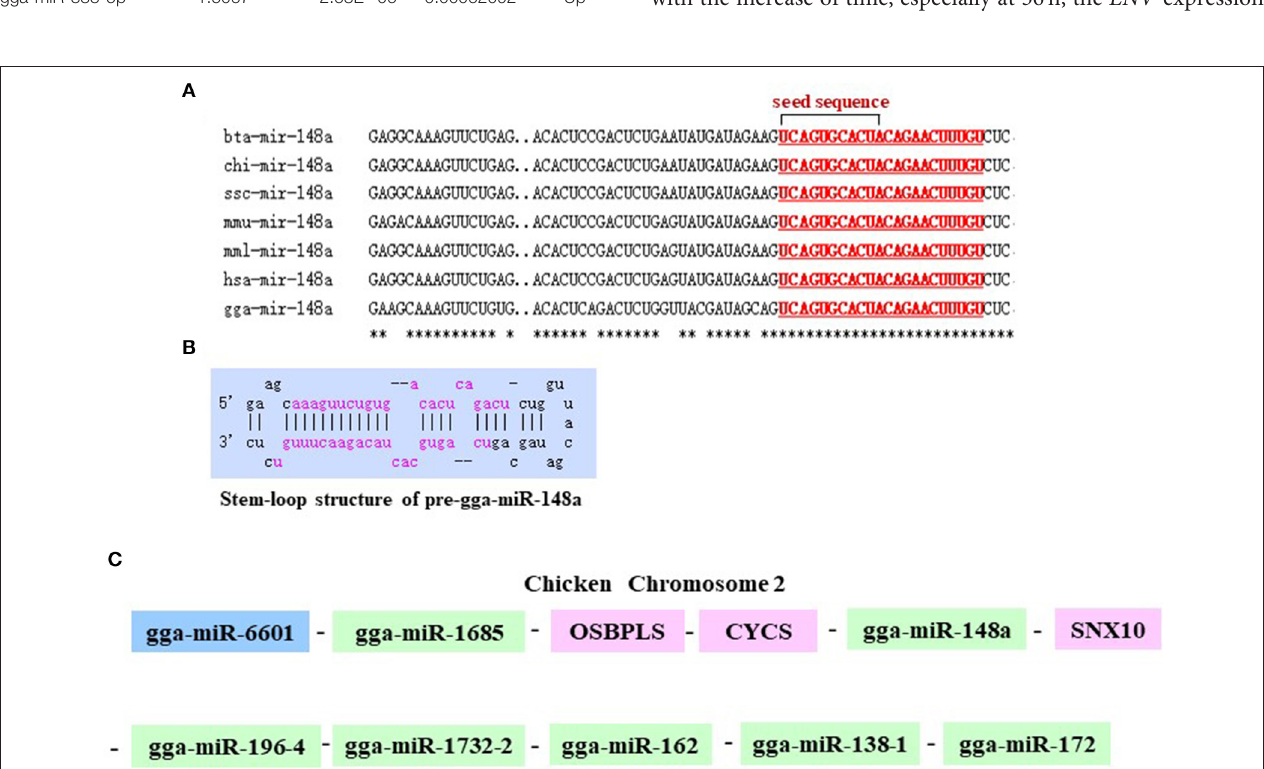
FIGURE 2 | Chromosomal position of gga-miR-148a and comparison of the gga-miR-148a sequences among several species. (A) Seed sequences of different species gga-miR-148a-5p. (B) Stem-loop structure of pre-gga-miR-148a-5p. (C) gga-miR-148a-5p is located on chicken chromosome 2.